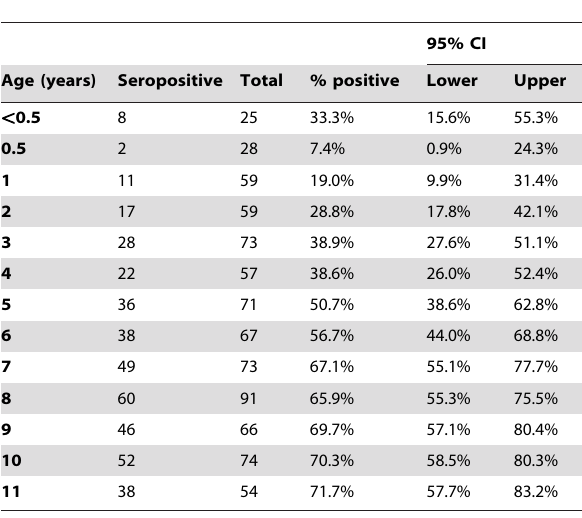
Table 1. Number and percentage of children positive for flavivirus antibodies, Colombo, Sri Lanka, 2008–9.